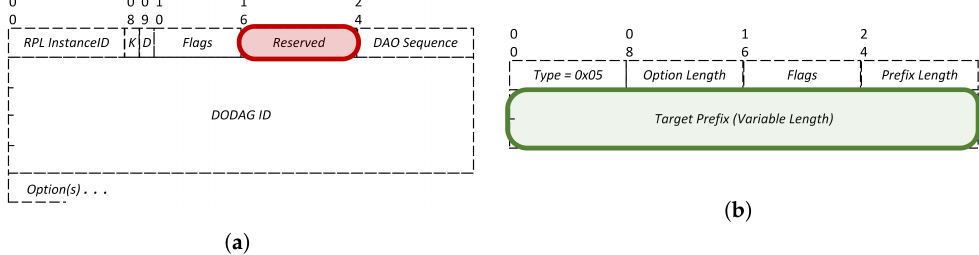
Figure 5. The structure of the DAO message and the RPL target option. The fields used in our implementation are marked. ( a ) Destination advertisement object (DAO) message structure. The reserved field is used for inserting the subtree size. ( b ) The structure of the RPL target